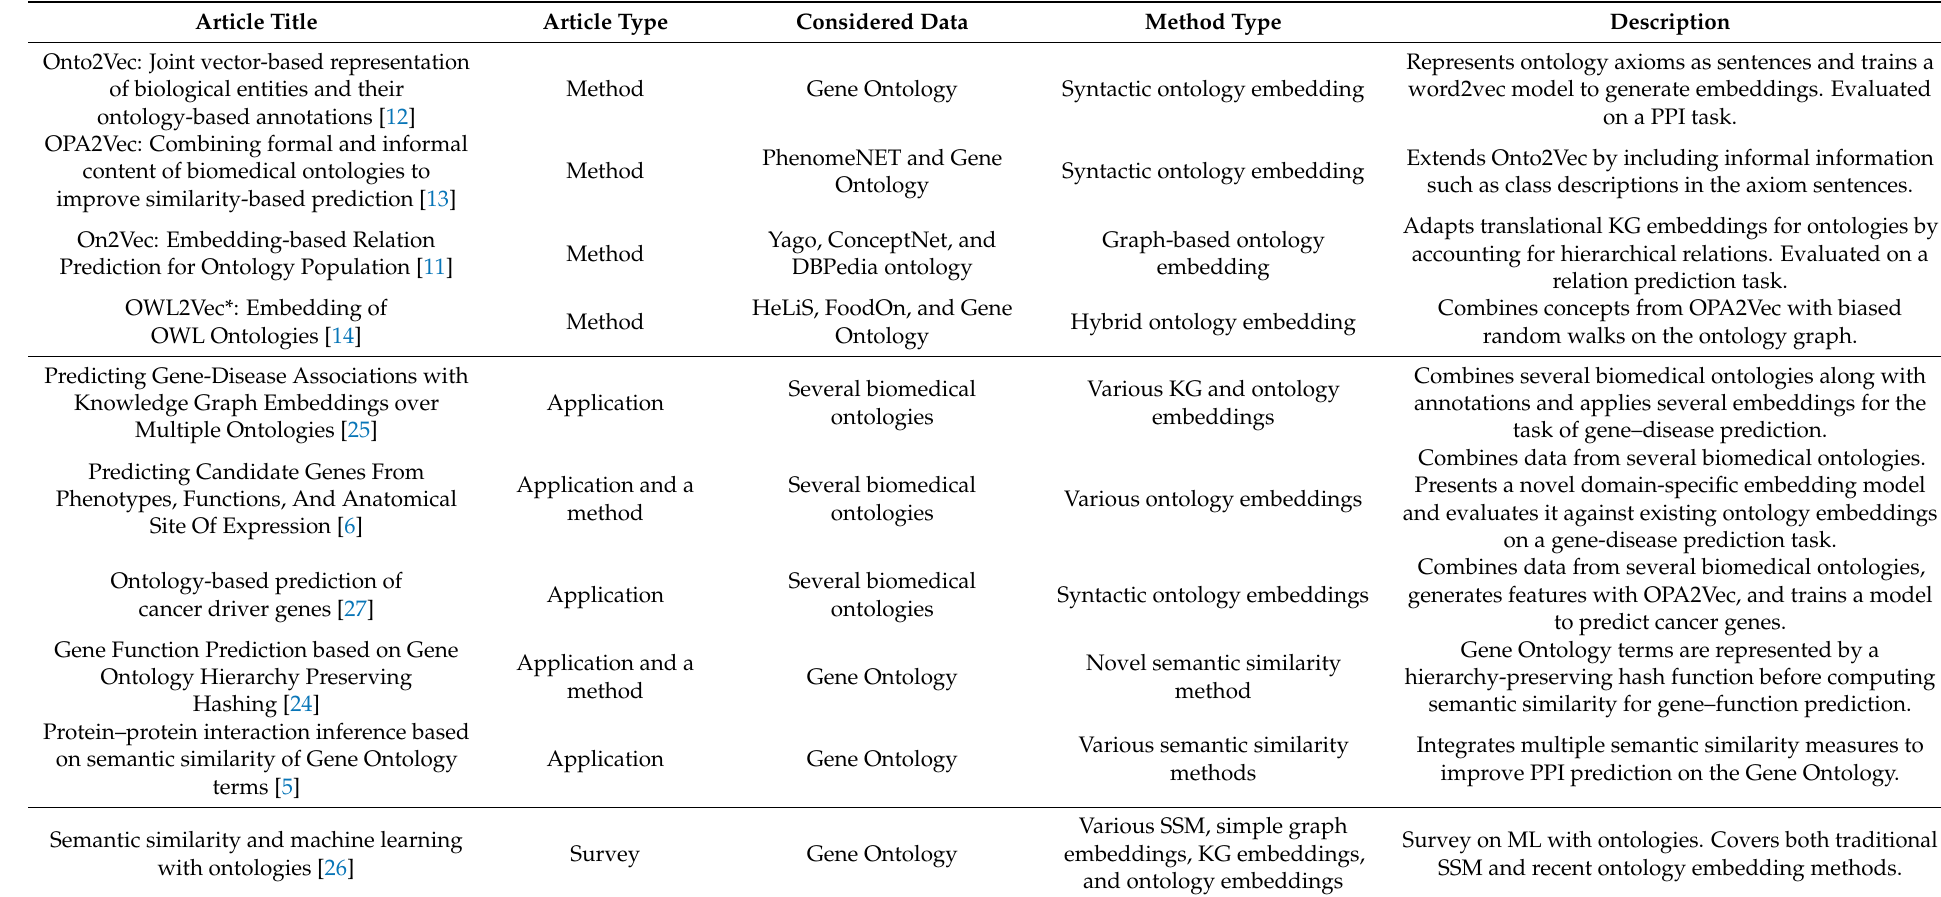
Table 1. Overview of some of the related approaches, their aim, and a short description. The horizontal lines separate different types of research